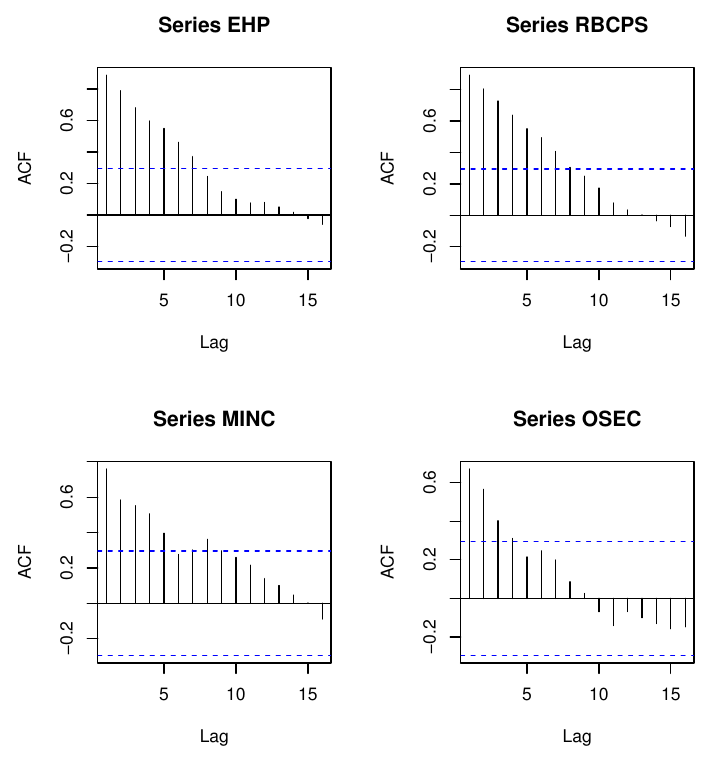
Figure 3. Autocorrelation function of CO 2 emissions